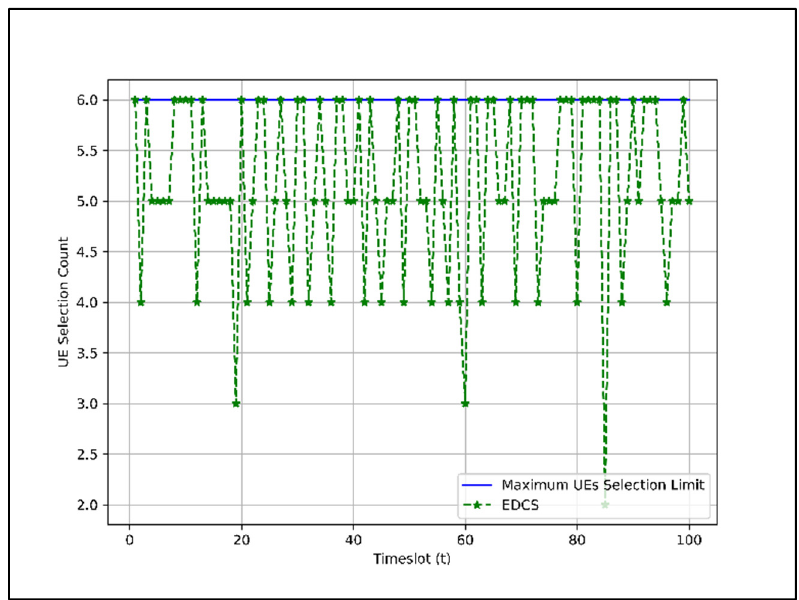
Figure 9. Total UEs selection count under EDCS for 100 timeslots.